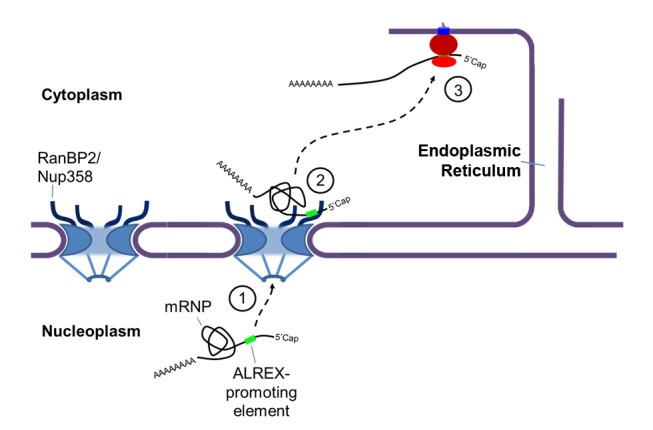
A general model of ALREX-regulated processes.(1) mRNAs containing ALREX-promoting SSCRs are packaged into mRNPs and exported by an unknown mechanism. (2) The exported mRNAs transiently interact with RanBP2 at the cytoplasmic face of the nuclear pore. This interaction likely causes some alteration within the mRNP. (3) Ultimately, this interaction promotes the translation of these mRNAs into secretory proteins at the surface of the ER.